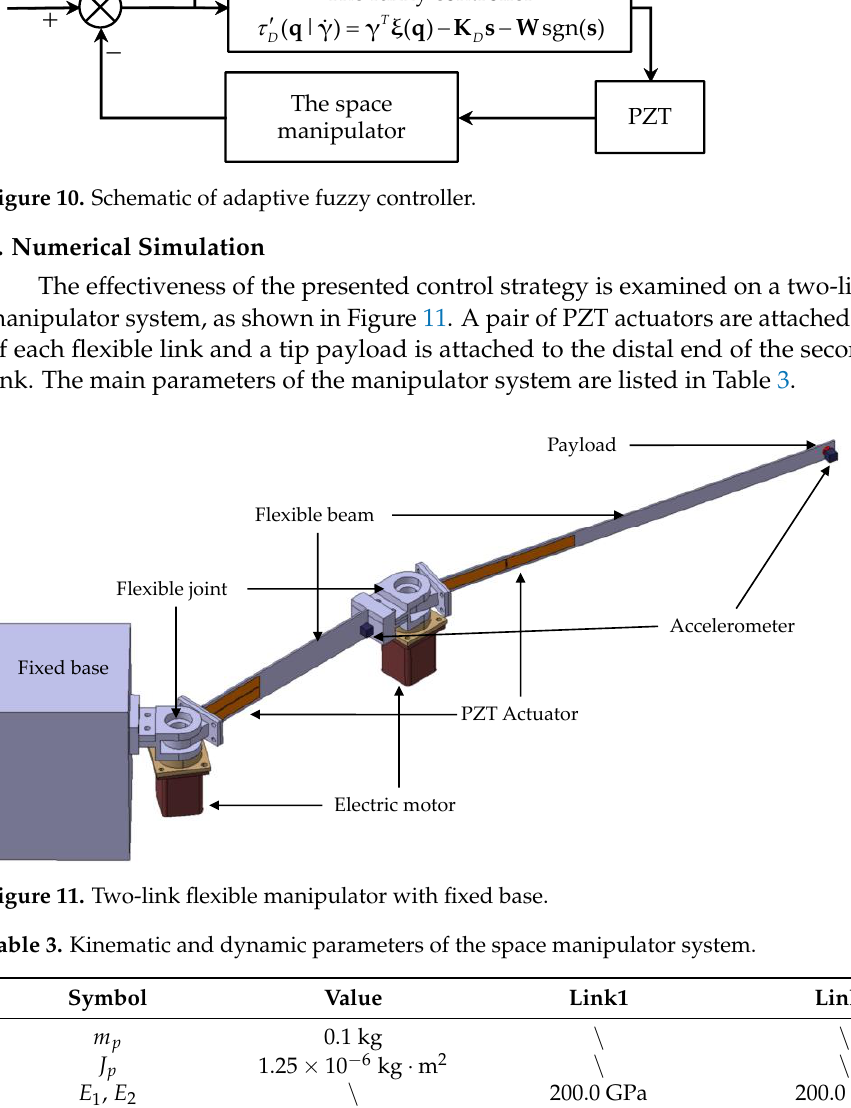
and 13, respectively. Define nine levels of fuzzy value: PB (positive big), PM (positive middle), PS (positive small), PO (positive zero), ZO (zero), NO (negative zero), NS (negative small), NM (negative middle), and NB (negative